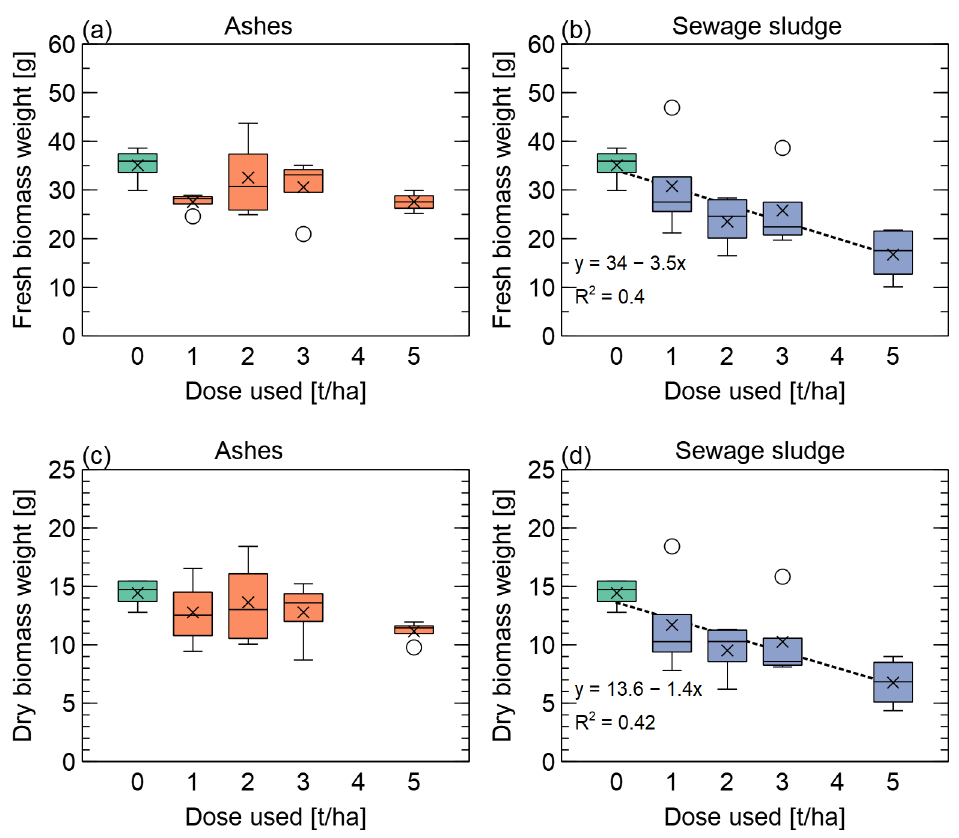
Figure 10. Fresh and dry biomass of Scots pine seedlings compared to preparation doses. Shown are two investigated variants of the mixture with ash ( a , c ) and sewage sludge ( b , d ). The dashed lines represent the linear regression fits of the data. The regression equations with the fitted parameters and the R 2 values of the models are shown in subfigures. The results of the regression analysis are presented only for the cases where the regression parameters are statistically significant at p < 0.05. In the plot, boxes span from 1st to 3rd quantile, with the median indicated by a line, whiskers indicating 1.5 inter-quantile range, the × symbol mean value, and circles outlier